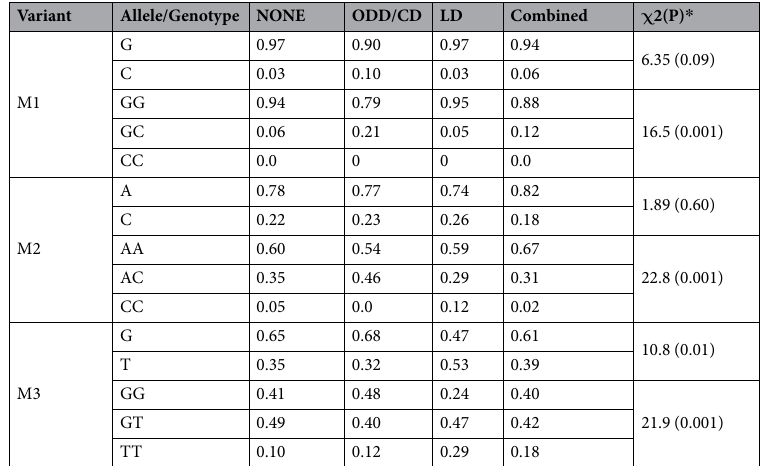
Table 5. Association of variants with ADHD in subjects with or without co-morbidity.